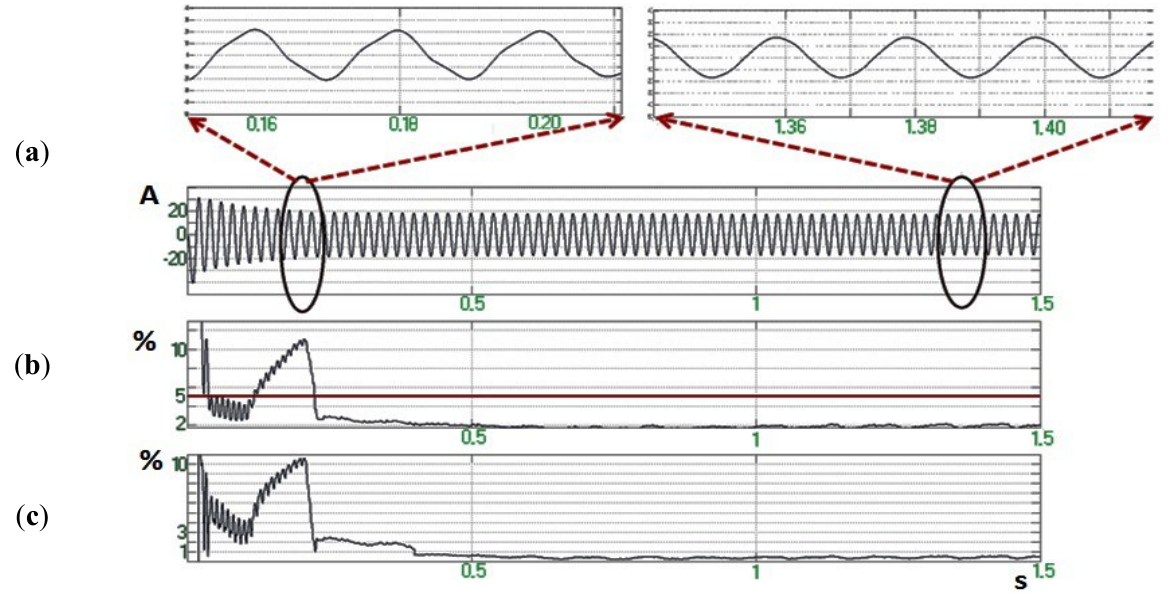
Figure 7. ( a ) Grid’s current 𝐼 ; ( b ) Grid’s current THD; ( c ) Grid’s current 3rd harmonic G component with higher harmonics